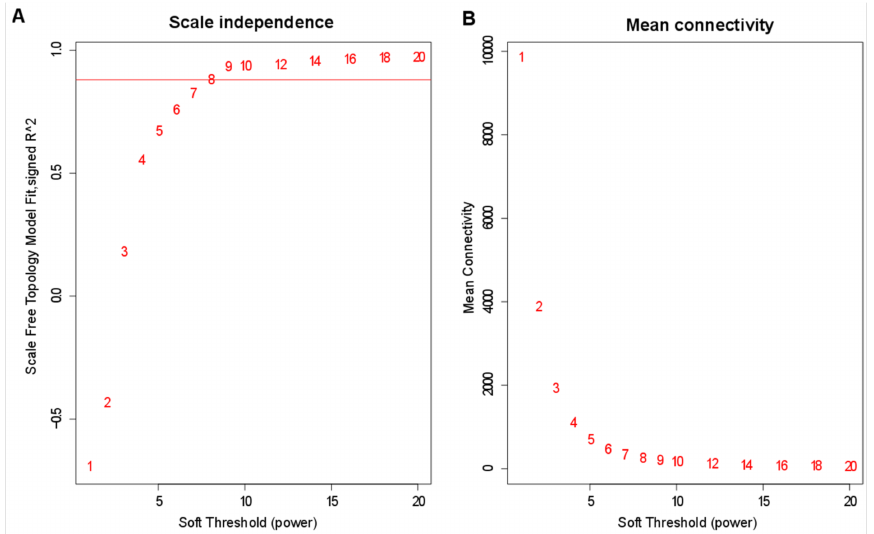
Figure 3. Module identification by weighted gene co-expression network analysis (WGCNA).